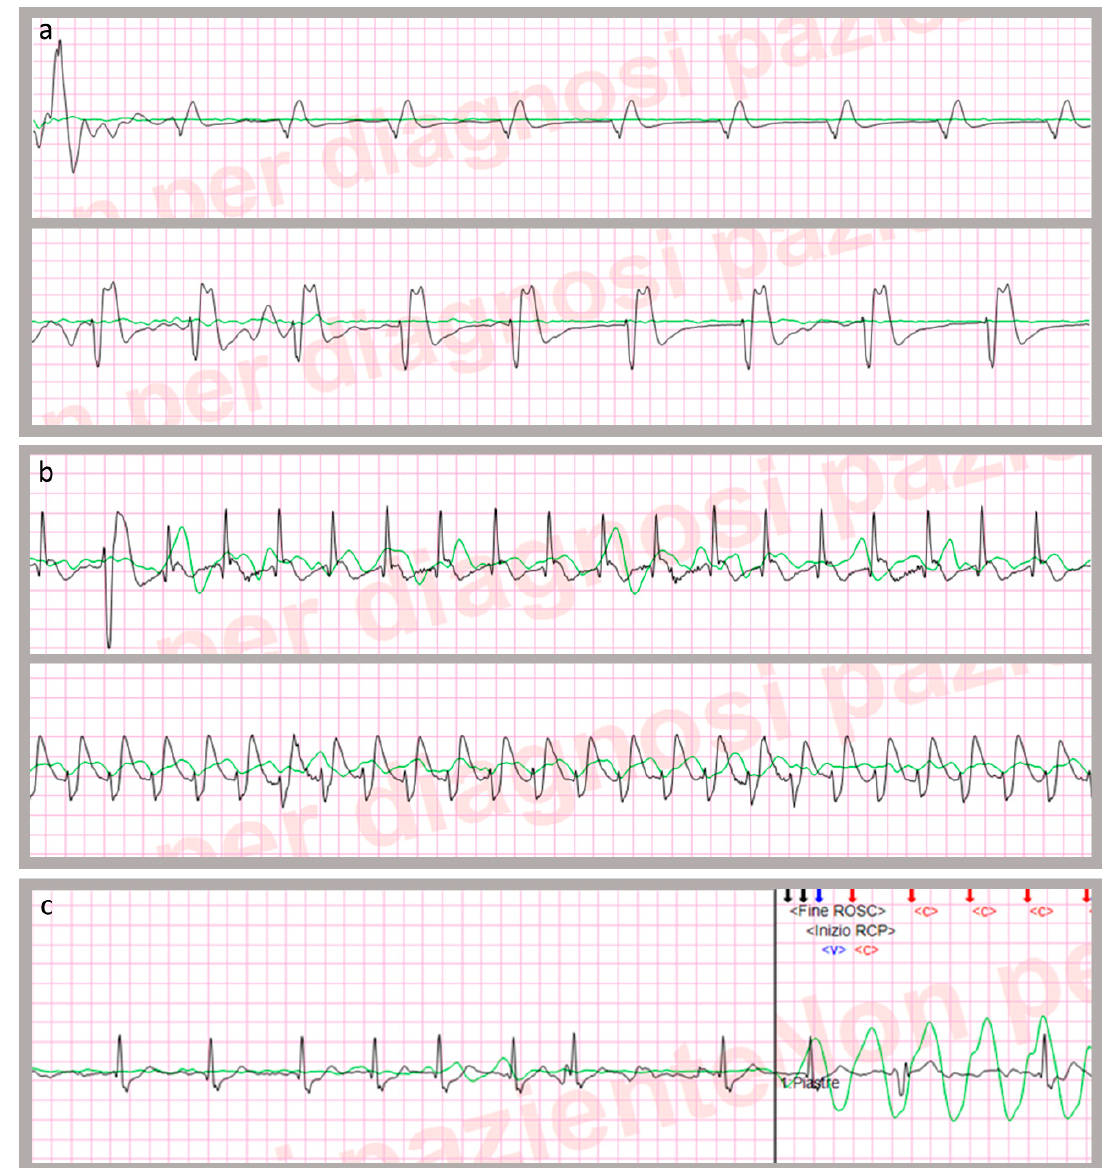
Figure 1. a . Examples of pulseless electrical activity (PEA) in two different patients. b . Examples of return of spontaneous circulation (ROSC) in two different patients. c . Example of resumption of cardio-pulmonary resuscitation in a patient who had a transitory ROSC. Green line: transthoracic impedance signal. Black line: electrocardiographic trace. <C>: chest compression. <V>: ventilation.